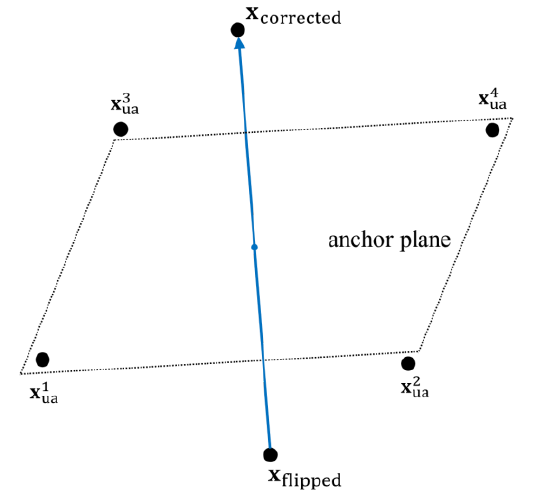
Figure 5. Q-drone with a UWB tag